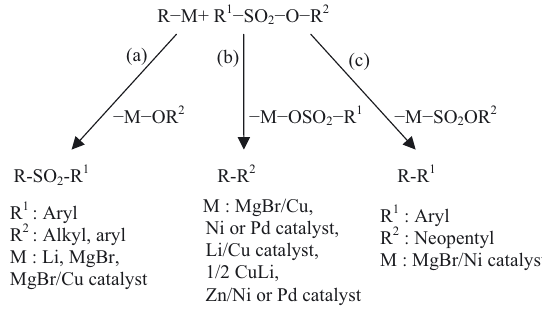
Scheme 1. Reactions of organometallic reagents with sulfonates. (a) C-S coupling reaction. (b) and (c) C-C coupling